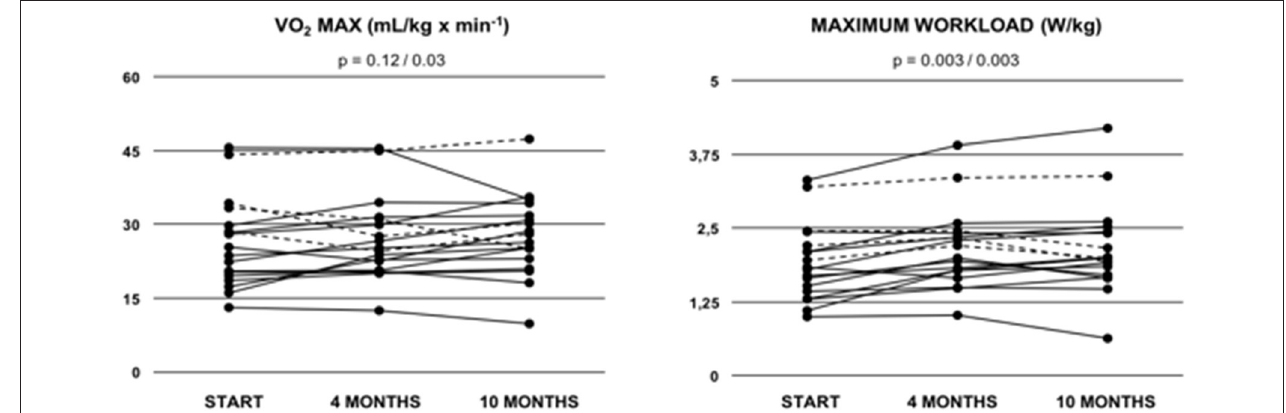
FIGURE 1 | Peak oxygen uptake (VO 2 MAX) and maximum relative workload (W/kg) in Fontan patients during the 10-months training period. Values are given at baseline (start), and after 4 and after 10 months of combined endurance and inspiratory muscle training. Each line represents one patient. Full lines represent teenage/adult patients, while dashed lines indicate patients who remained younger than 13 years throughout the study period. The first p -value refers to the total cohort of 18 patients, while the second p -value refers to the teenage/adult subgroup analyses only ( n = 14).